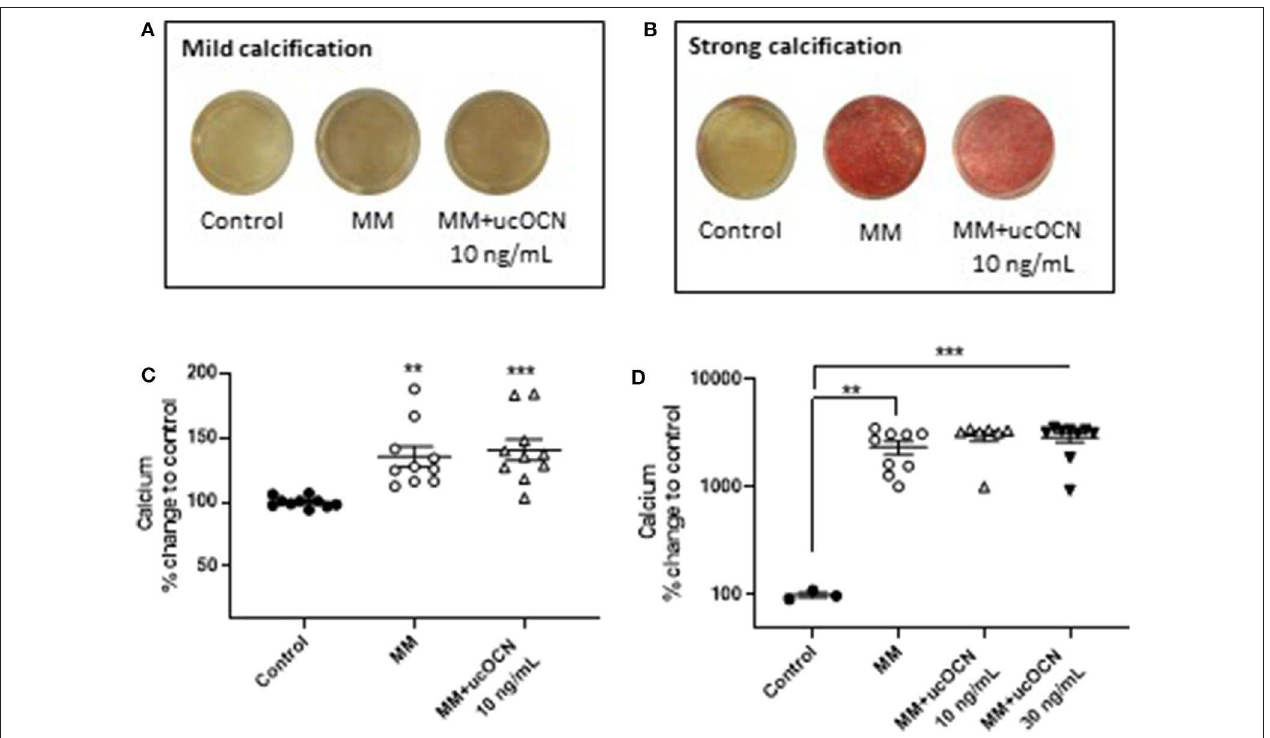
FIGURE 4 | Human aortic smooth muscle cells (SMCs) were maintained in control media or mineralisation inducing media (MM). After 21 days, alizarin red staining was used to visualize calcification and calcium quantification was determined using a calcium assay. In some experiments SMCs mildly or moderately calcified (A,C) while in others they were strongly calcified (B,D) . Data are presented as means with error bars representing SEM. Data were analyzed by one-way ANOVA with ** p < 0.01 and *** p < 0.001 compared to